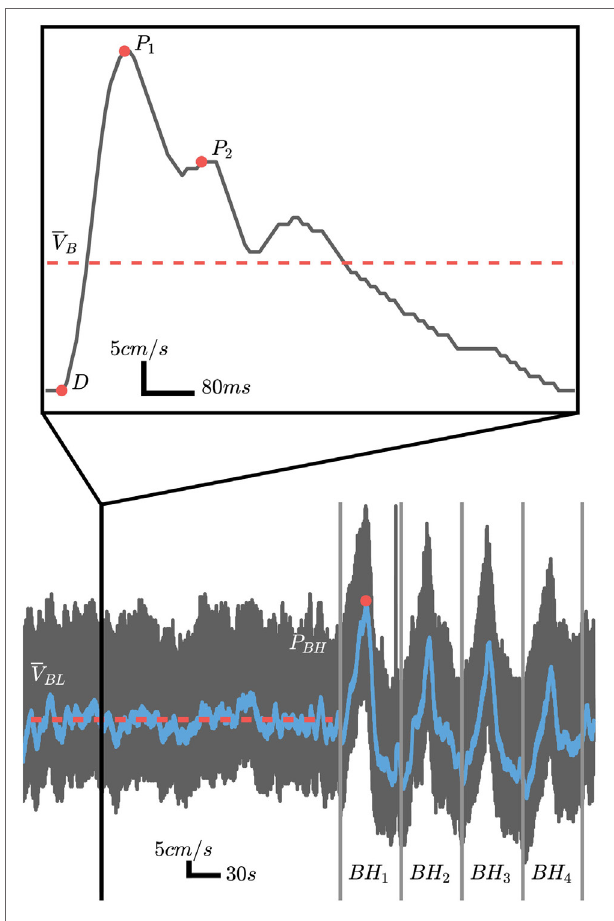
FigUre 2 | Representative cerebral blood flow velocity (CBFV) signal over the course of the experimental protocol (black trace) with the filtered signal used for cerebrovascular reactivity (CVR) calculations overlaid (blue trace). For CVR calculations, the baseline mean velocity (MVb) is computed over the period highlighted by the solid red line and the peak is velocity is computed from the breath hold period with the highest peak as illustrated by the red circle in BH1. The pulsatile analysis is computed using baseline pulses as illustrated by the inlay outlined by the solid vertical black lines. The systolic (P1), diastolic (D), and second peak (P2) are marked by the solid red